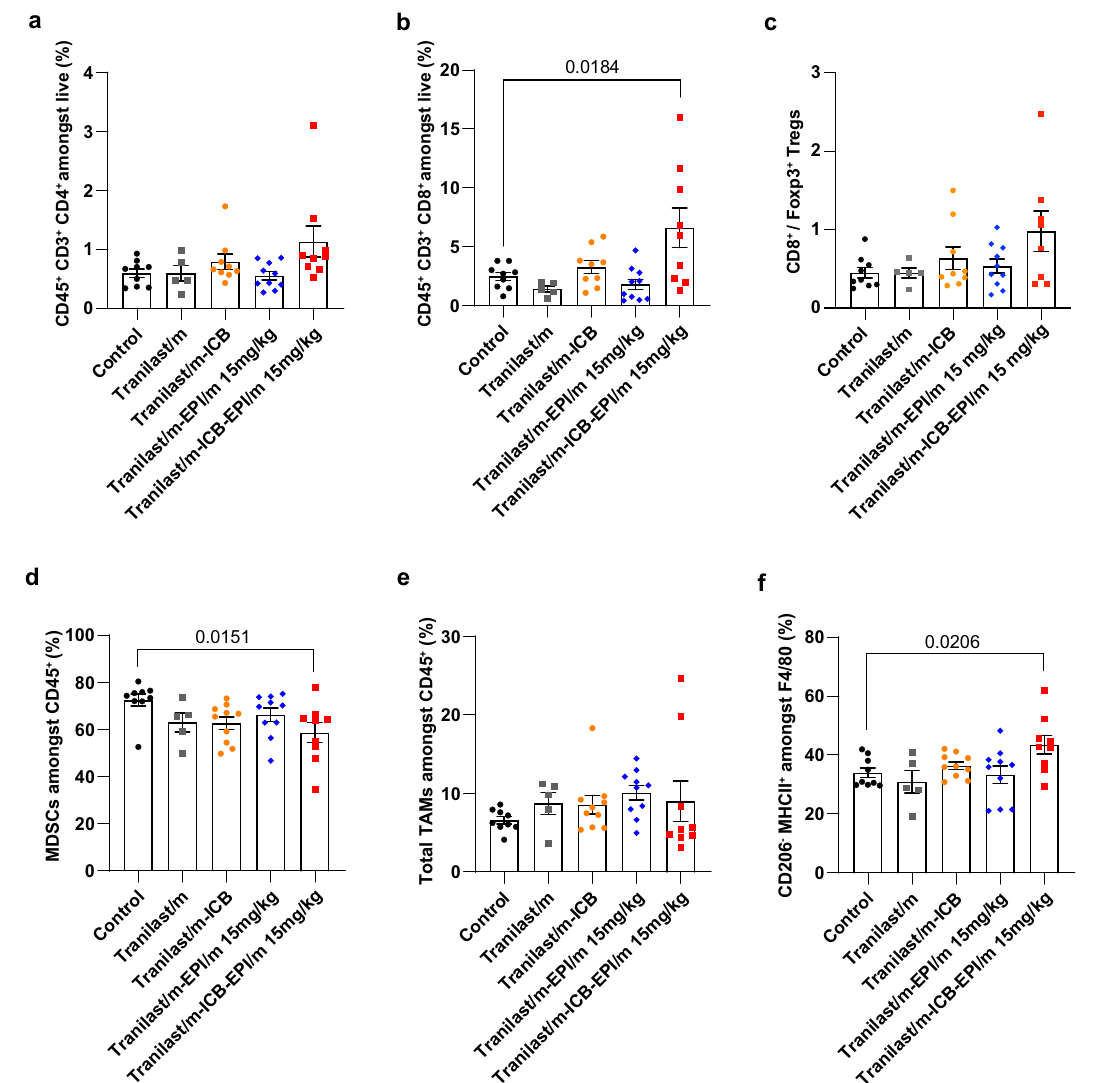
Fig.5|Tranilastmicellescombinedwithnano-immunotherapyenhancetumor immunogenicity. a Percentages of intratumoral CD45 + CD3 + CD4 + (SP, single positive)cellpopulationand( b )percentagesofintratumoralCD45 + CD3 + CD8 +